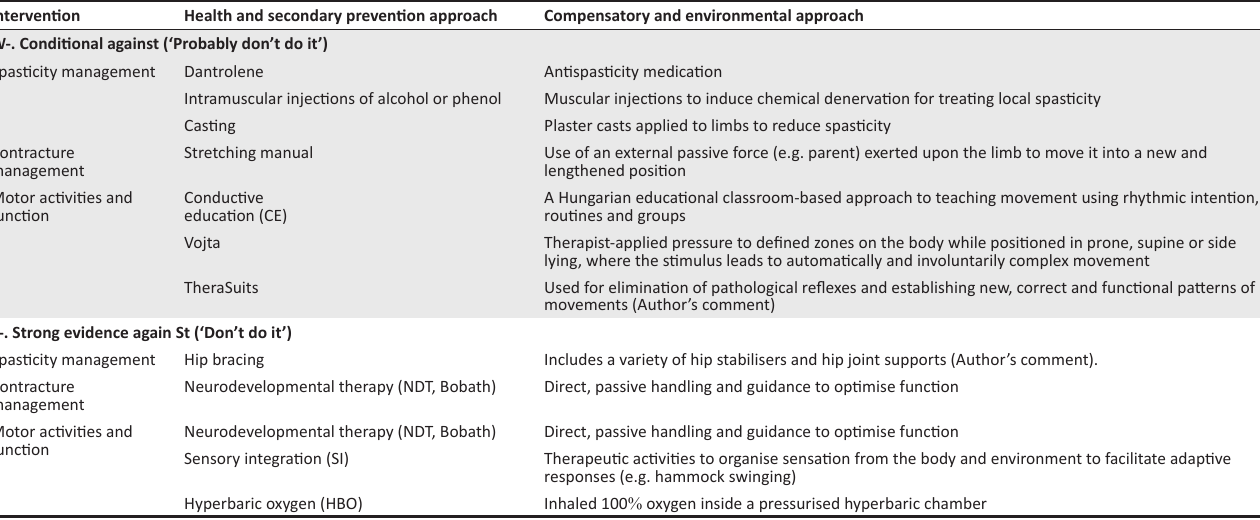
TABLE 1-A1 (Continues...): Levels of evidence (GRADE † ) for intervention options relevant for pain management. Descriptions from Novak et al. (2013:888–897) or Novak (2014:1148–1151).